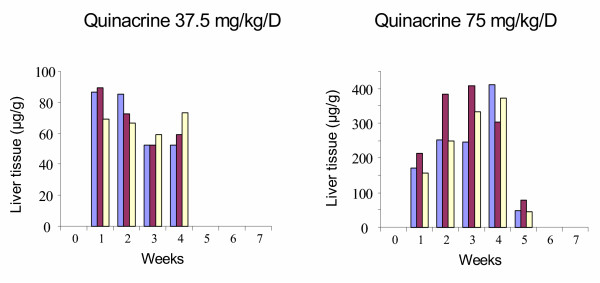
Quinacrine liver levels in mice (FVB strain) administered oral quinacrine at 37.5 or 75 mg/kg/D for 4 weeks